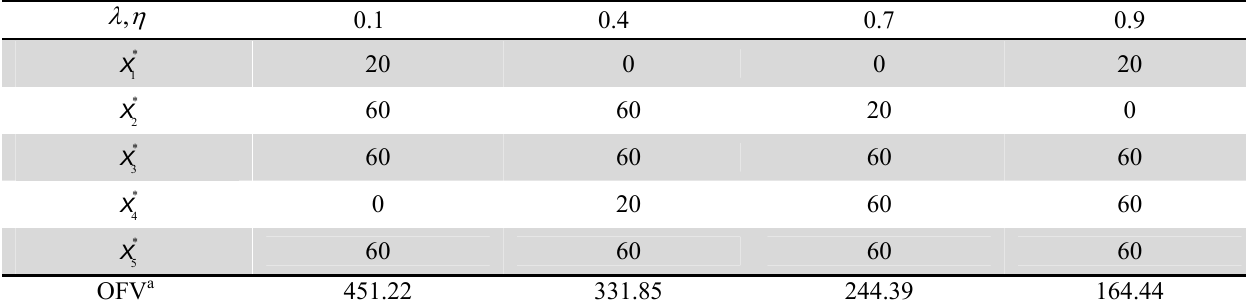
Numerical results (possibility-based model) , 